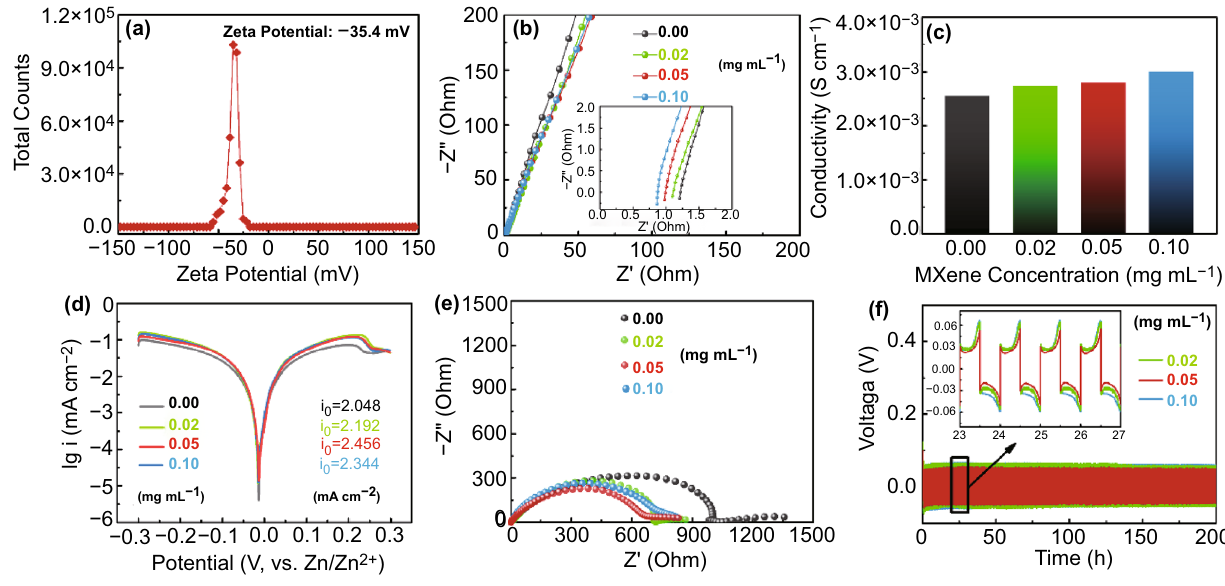
Fig. 2 a Zeta potential distribution of the MXene nanosheets dispersed in water. b EIS of SS-SC cell in the electrolyte with different MXene concentrations. Insertion is the magnified curves of EIS at the high-frequency region. c Ionic conductivities of electrolytes with different MXene concentrations. d Linear polarization curves in the electrolyte with different MXene concentrations. e EIS of Zn-Zn symmetrical cell in the electrolyte with different MXene concentrations. f Galvanostatic cycling of Zn-Zn symmetrical cell at current density of 2 mA cm −2